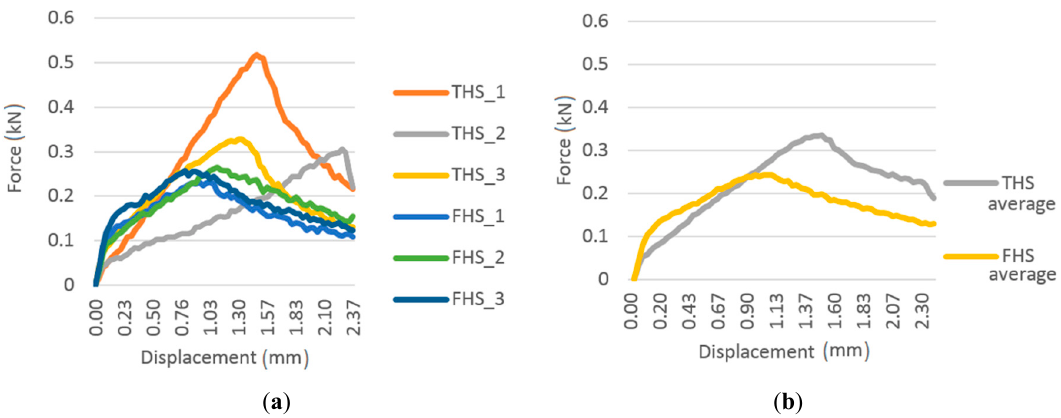
Figure 8. Flexural force-displacement relationship: all samples (a) and average values (b) .